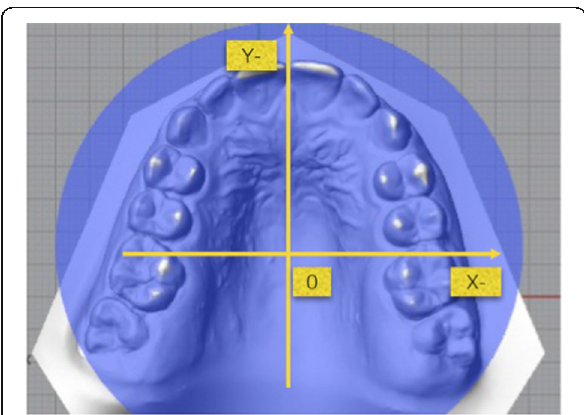
Fig. 5 Occlusal plane of